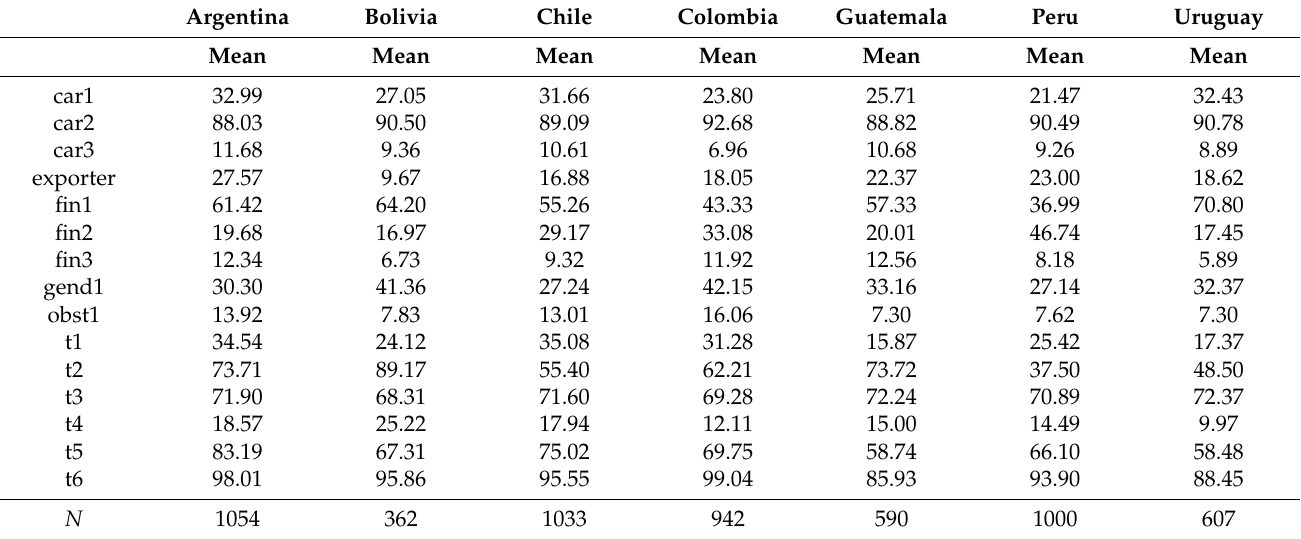
Table 3. Descriptive statistics of Latin American countries in 2010.